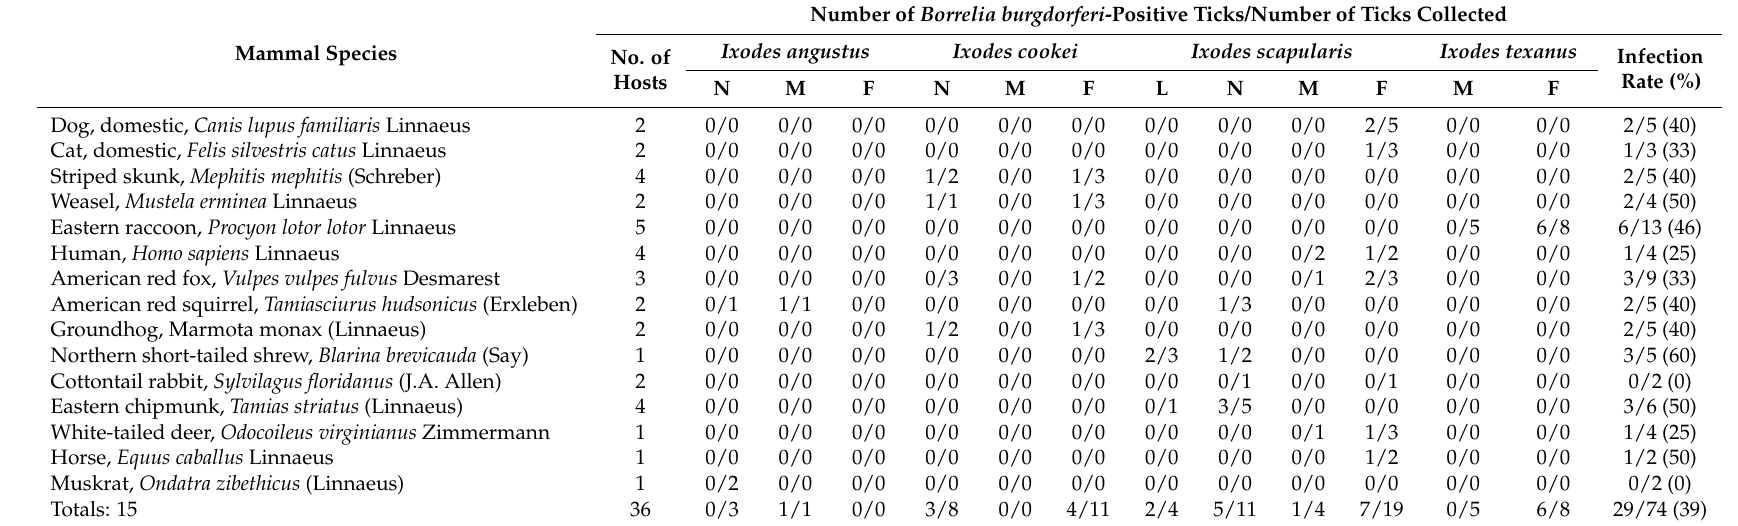
Table 5. Detection of Borrelia burgdorferi sensu lato in Ixodes ticks collected from mammalian hosts in the London-St. Thomas-Simcoe-Toronto, Ontario area, 2013–2016. Number of Borrelia burgdorferi -Positive Ticks/Number of Ticks Collected Ixodes Mammal Species No. of Hosts